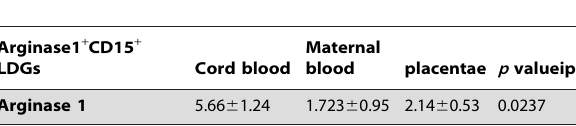
Table 5. Percent of Arginase1 + CD15 + LDGs present in placentae, cord blood and maternal